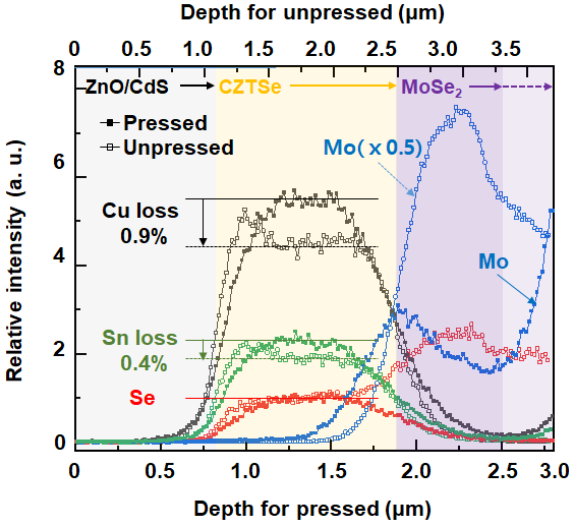
Figure 5. Dynamic SIMS elemental profiles of CZTSe/MoSe 2 layer from the unpressed (unfilled squares) and the pressed (filled squares) devices. For comparison, the CZTSe thickness was normalized.